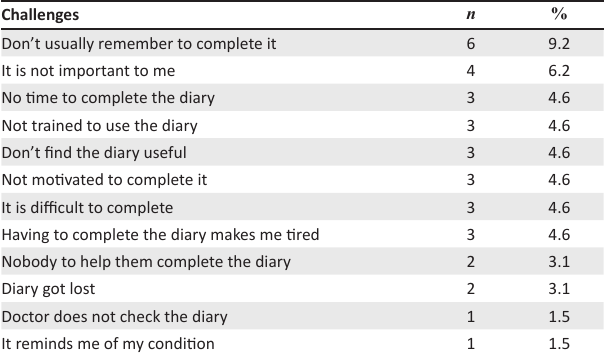
TABLE 4: Challenges with keeping a seizure diary.